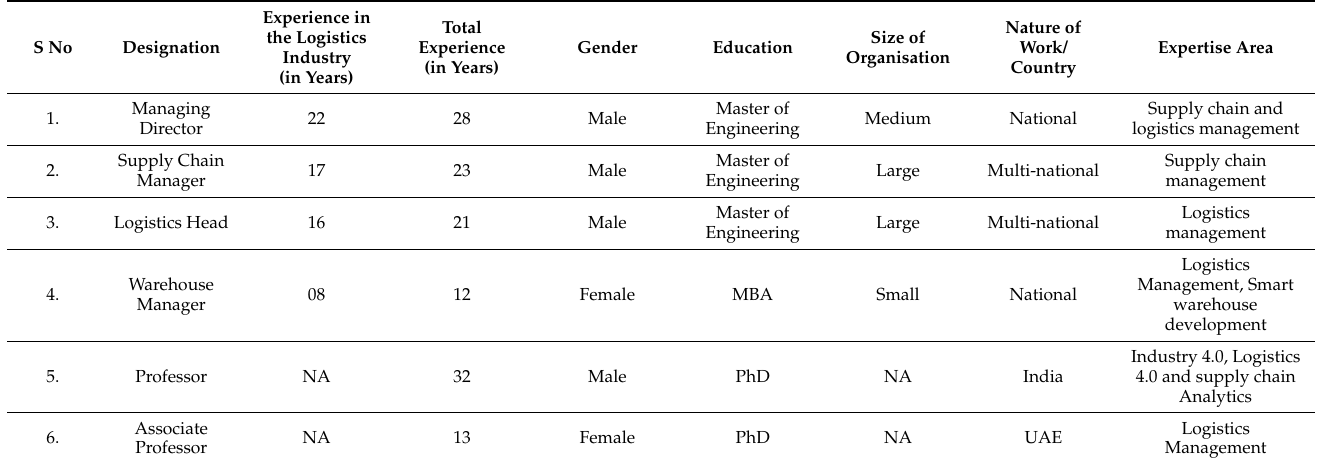
Table 2. Details of the participated